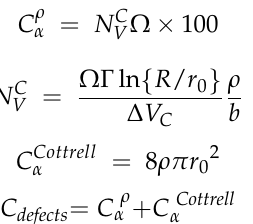
( c ) the carbon distribution at t = 0.001 s.